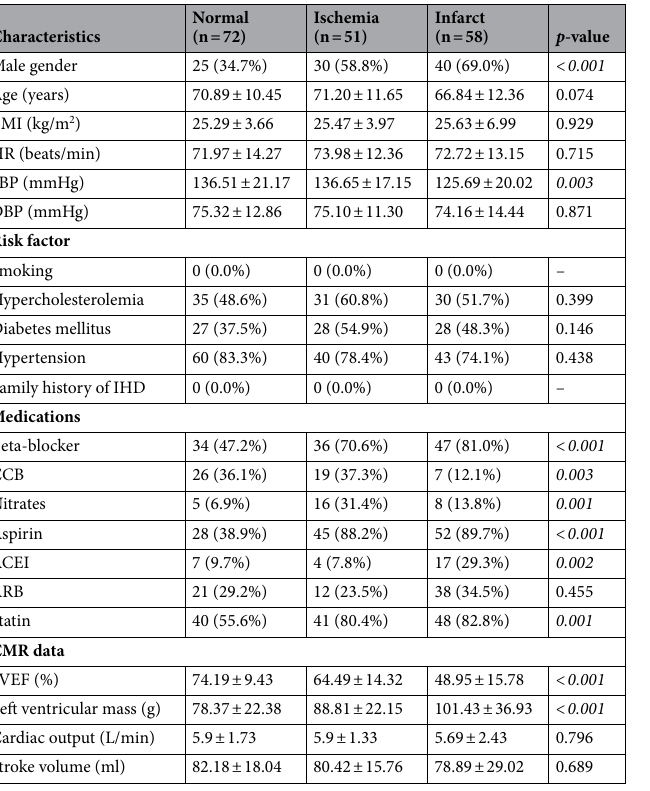
Table 2. Baseline demographic and clinical characteristics of the study population. Data presented in mean ± standard deviation. A p -value < 0.05 indicates statistical significance (italics). BMI body mass index, HR heart rate, SBP systolic blood pressure, DBP diastolic blood pressure, IHD ischemic heart disease, CCB calcium channel blocker, ACEI angiotensin converting enzyme inhibitor, ARB angiotensin receptor blocker, CMR cardiac magnetic resonance, LVEF left ventricular ejection